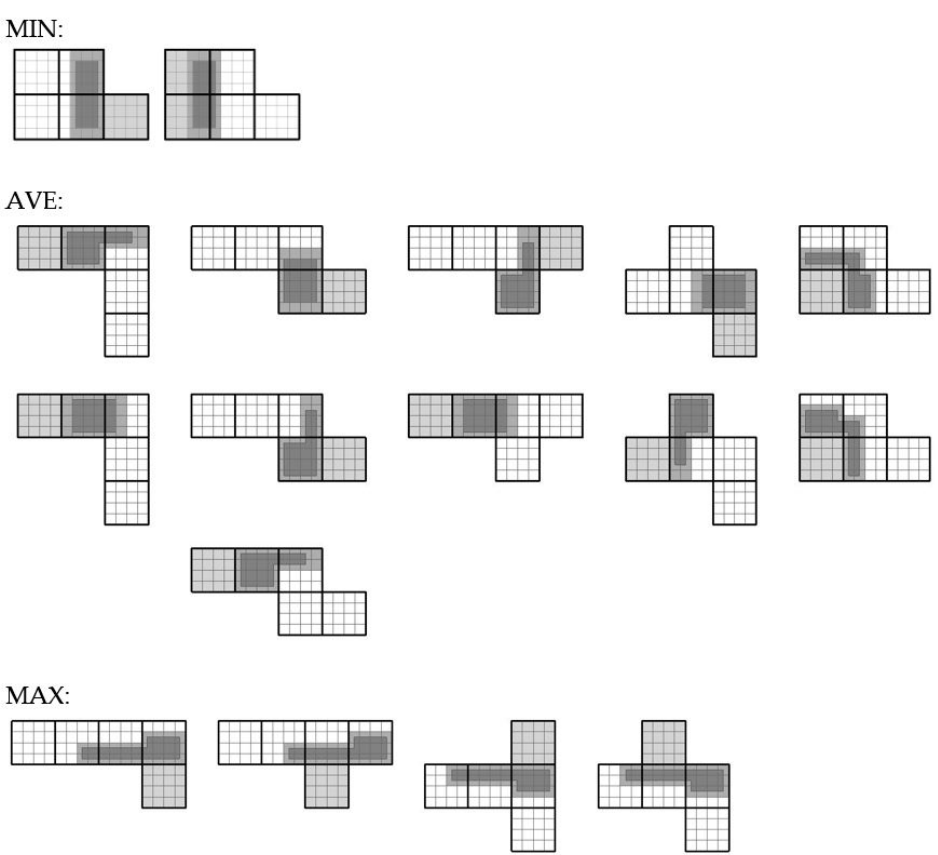
Figure 21. New A/S groups with internal space organization.